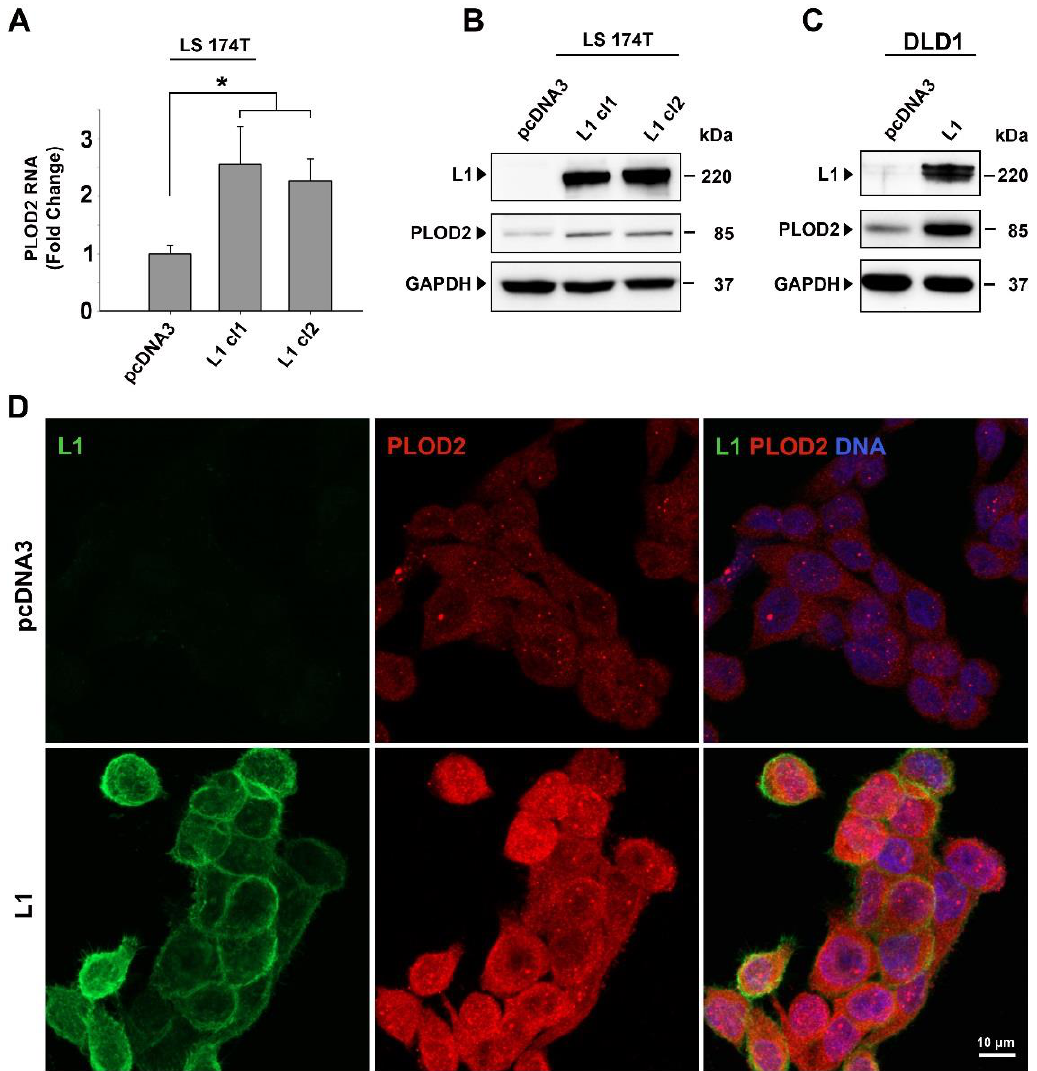
Figure 1. Induction of lysyl hydroxylase 2 (PLOD2) expression in colorectal cancer (CRC) cells by the overexpression of L1. ( A ) The level of PLOD2 RNA was determined in control clones of LS 174T transfected with pcDNA3 and in LS 174T CRC cell clones stably overexpressing L1 (L1 cl1 and cl2) by RT-PCR. ( B ) Western blot analysis of PLOD2 protein levels in the CRC cell lines described in ( A ). ( C ) Western blot analysis of PLOD2 protein levels in DLD1 CRC cells transfected with pcDNA3 or with L1. ( D ) Double immunofluorescence localization and levels of PLOD2 (red) and L1 (green) in LS 174T CRC cells expressing the control pcDNA3 plasmid or L1. DNA was visualized using DAPI (blue). * p < 0.05.